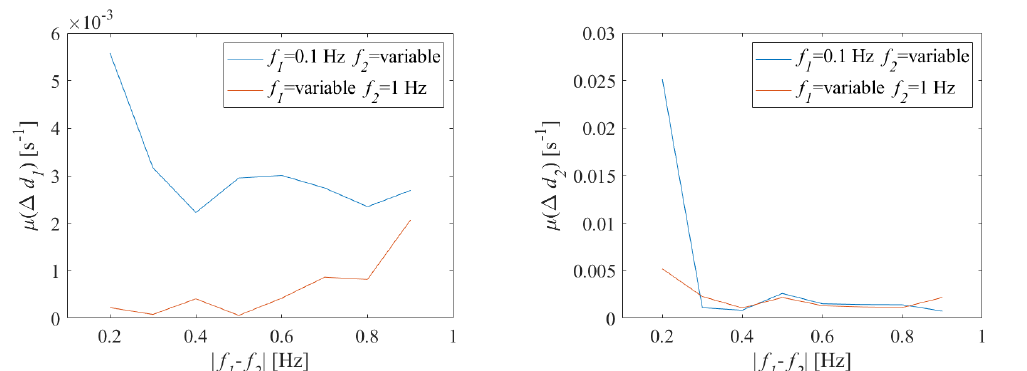
Figure 15. Mean of ∆ d versus the frequency distance between the components obtained in experimental tests with digitized signals; results for components with damping d 1 ( on the left ) and damping d 2 ( on the right ).